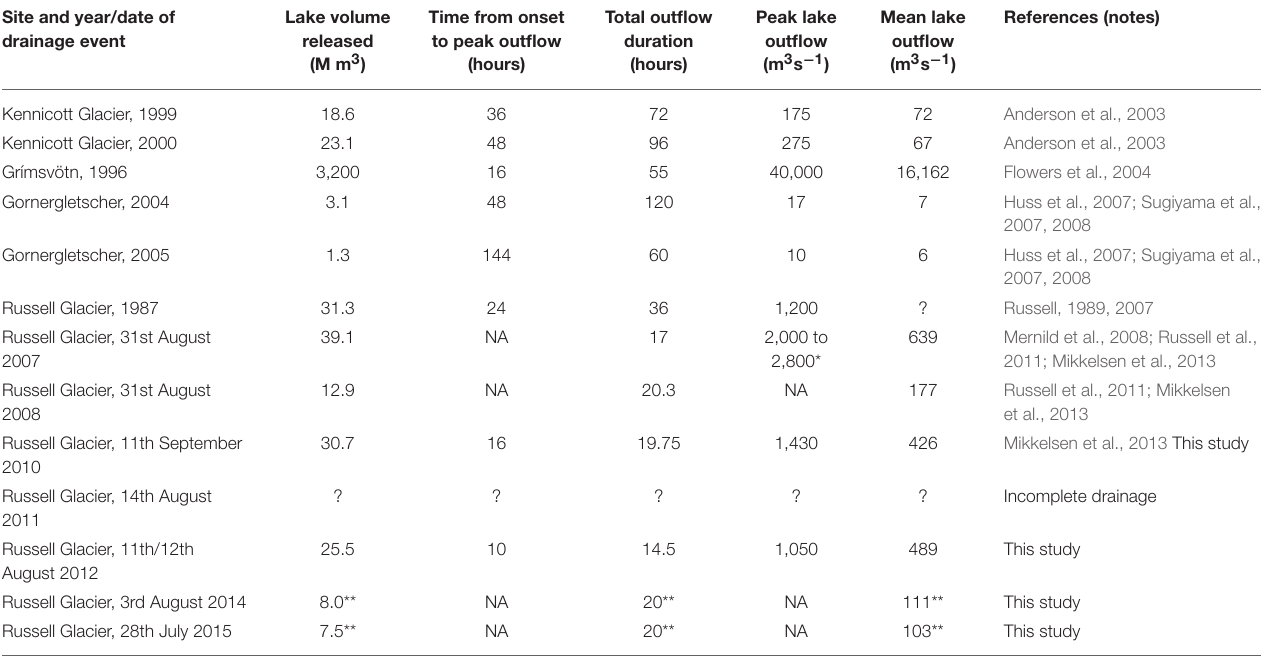
TABLE 1 | Metrics for events where both transient lake level measurements have been obtained and also to where lake bathymetry is known, together permitting lake outflow (discharge) to be calculated. Site and year/date of drainage